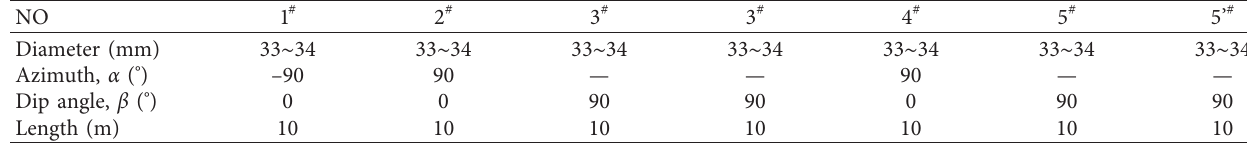
Table 8: Design parameters of boreholes for